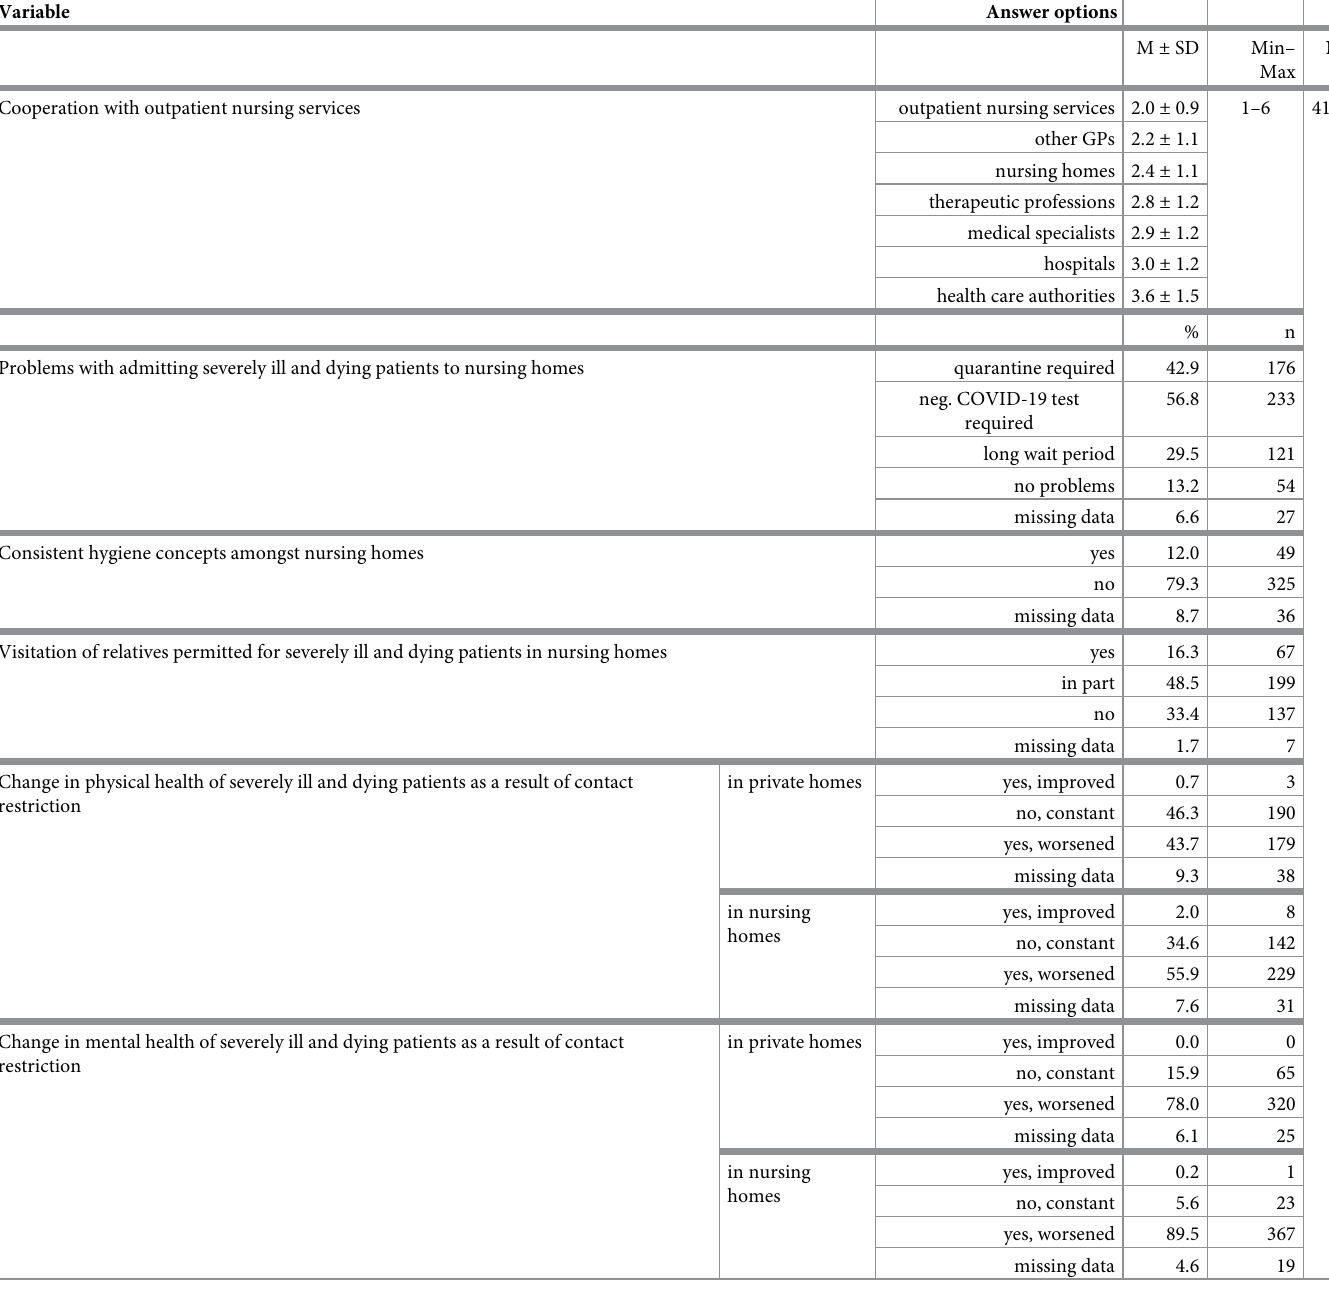
Table 3. Cooperation with other health care